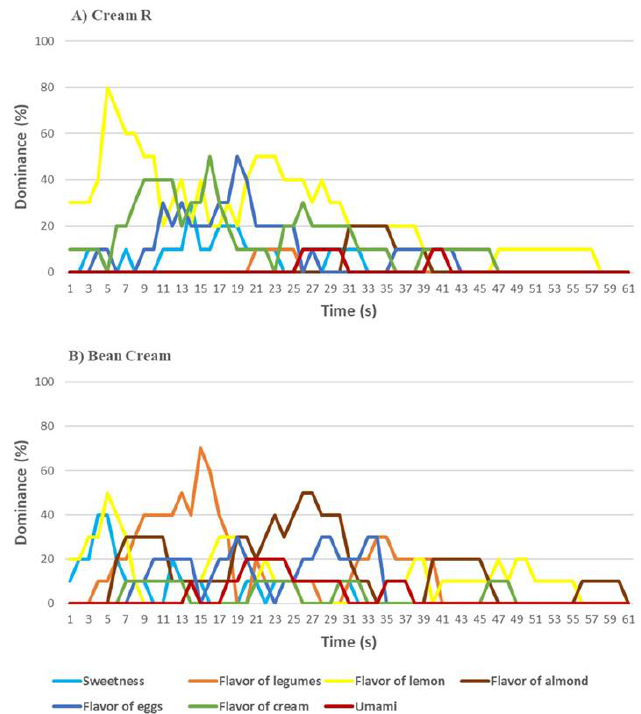
Figure 11. Temporal dominance of sensations (TDS) of ( A ) Cream R (reference, without common bean flour) and ( B ) Bean Cream (with 9% common bean